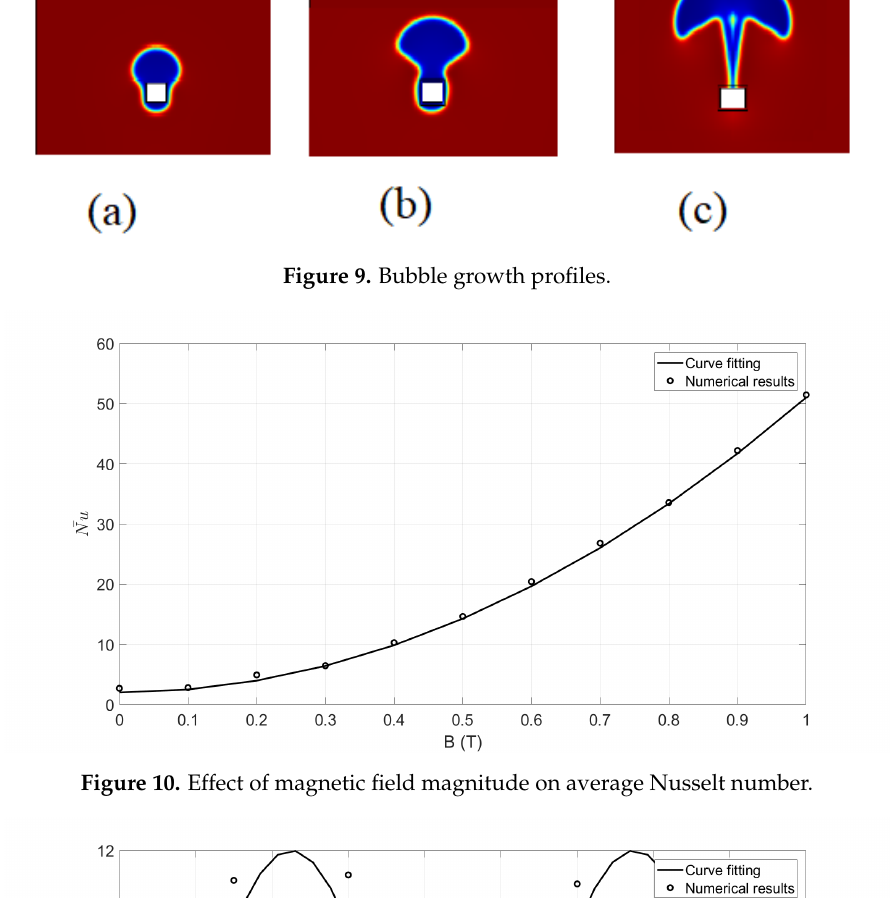
Figure 10. Effect of magnetic field magnitude on average Nusselt number.